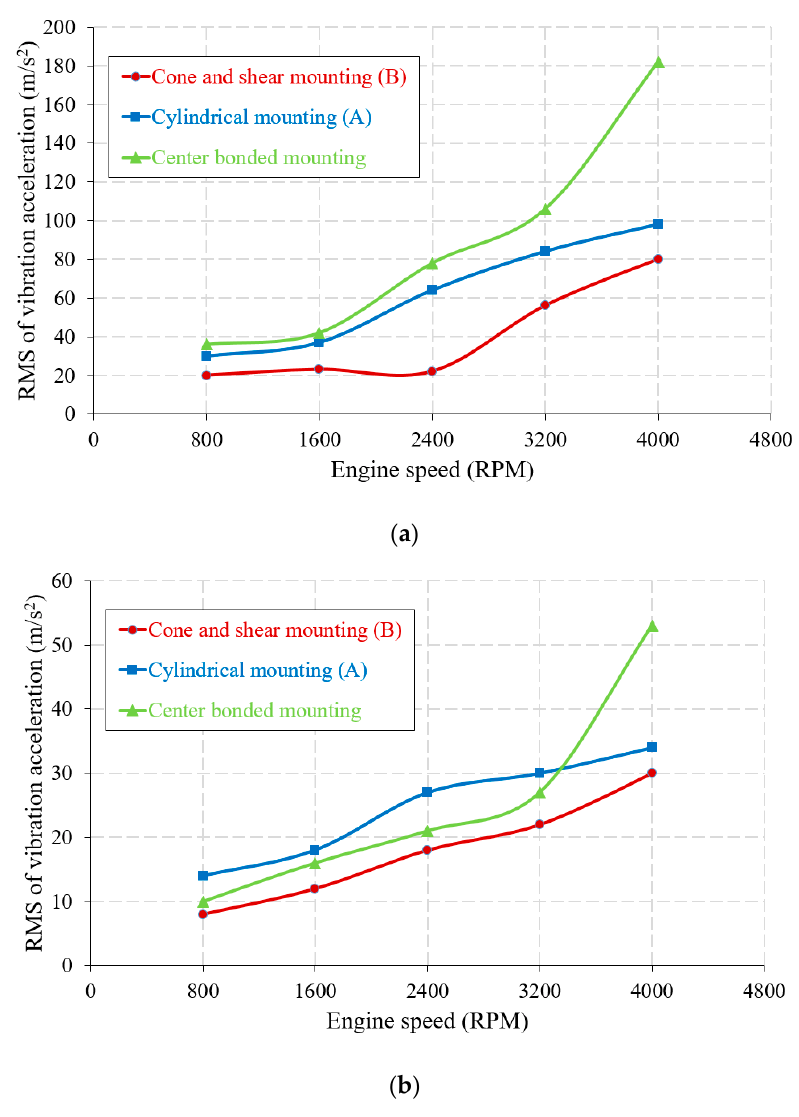
Figure 2. RMS of vibration accelerations of ( a ) engine; ( b ) chassis [14].